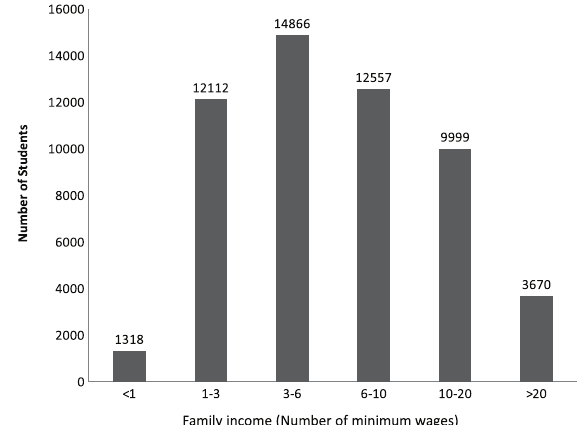
Figure 8 - Number (and %) of undergraduate SwB student by family income as measured by number of minimum wages.